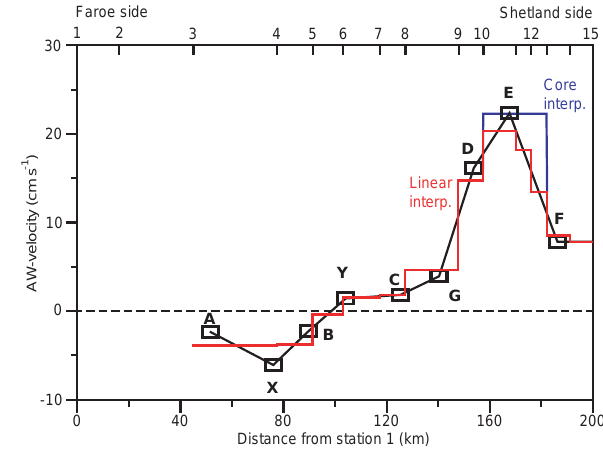
Fig. 6. AW velocity plotted against distance from the first CTD sta- tion on the Faroe side (see Fig. 2 for locations). Open rectangles indicate average altimetry-adjusted velocities (last column in Ta- ble 4) and the black line shows a linear variation between them. CTD station locations are shown at the top and the red and blue lines indicate AW velocity calculated from the adjusted geostrophic profiles using two alternative interpolation schemes, as discussed in the